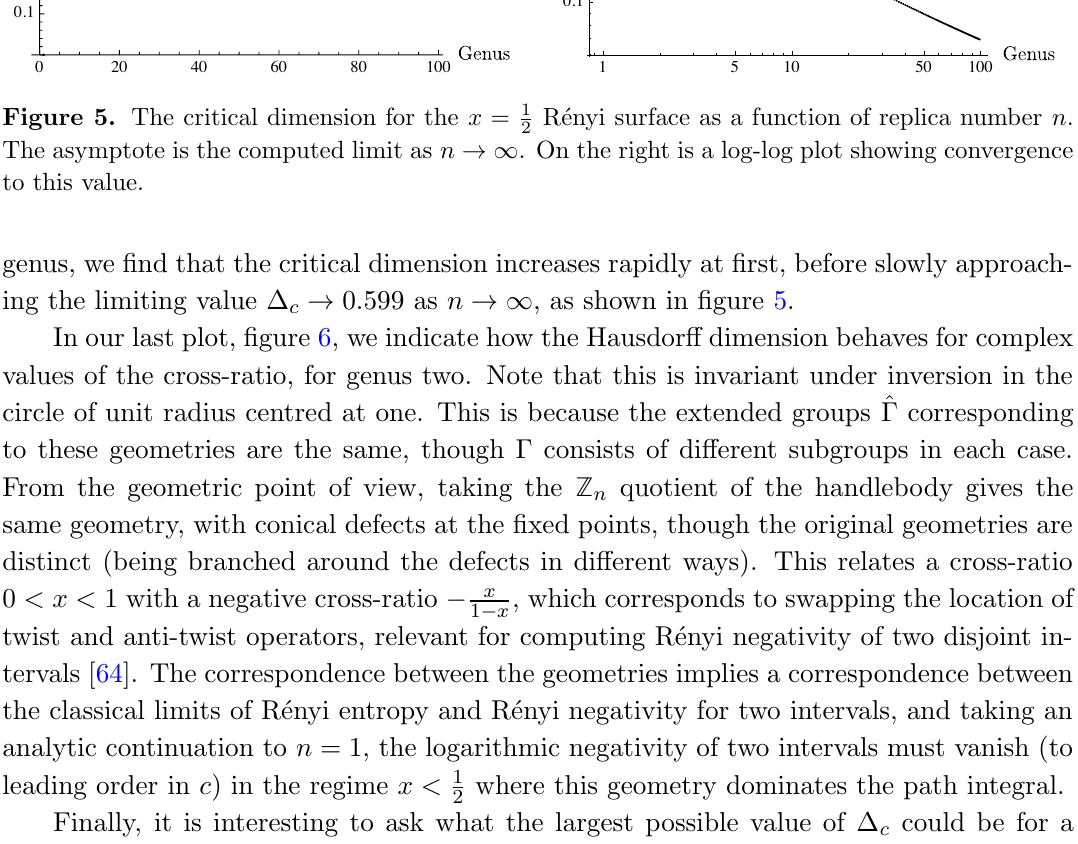
R(cid:19)enyi surface as a function of replica number n . 2